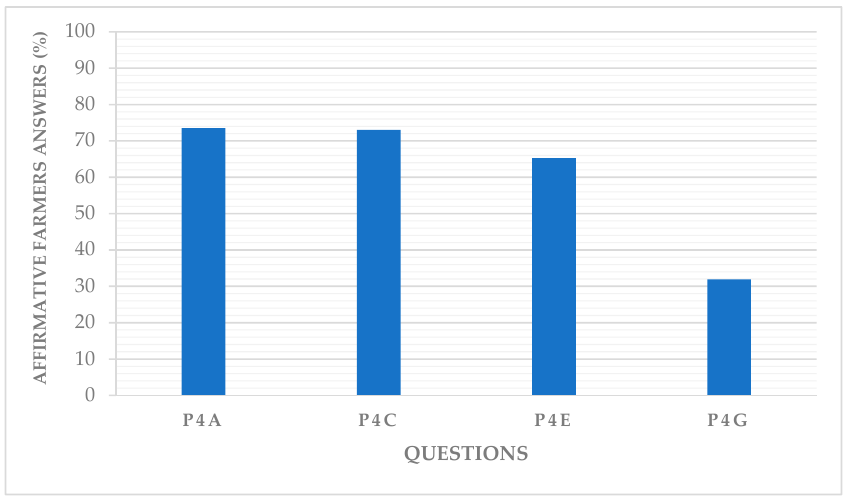
Figure 7. Farmers answers for questions in Block 3.